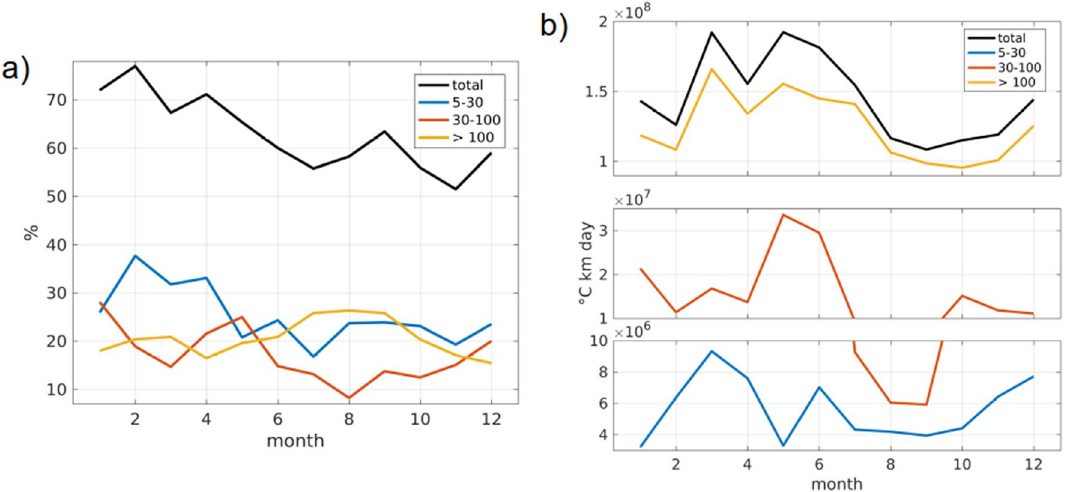
Figure 4. ( a ) Monthly percentage of exposure, i.e. proportion of days affected by a MHW anywhere in the coastal domain and, ( b ) resulting net heating, i.e. SST anomaly summed over space and time. Results are